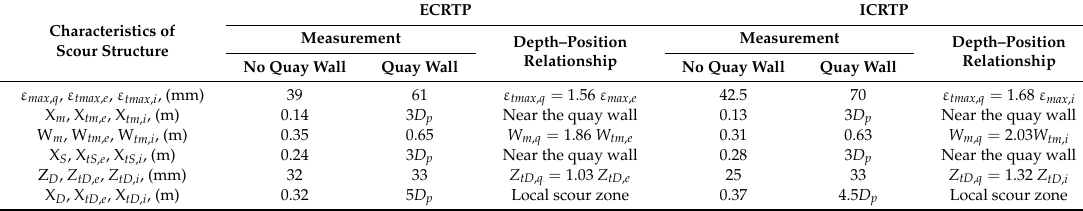
Table 4. Comparison of scour structures of ECRTP and ICRTP at 3 D